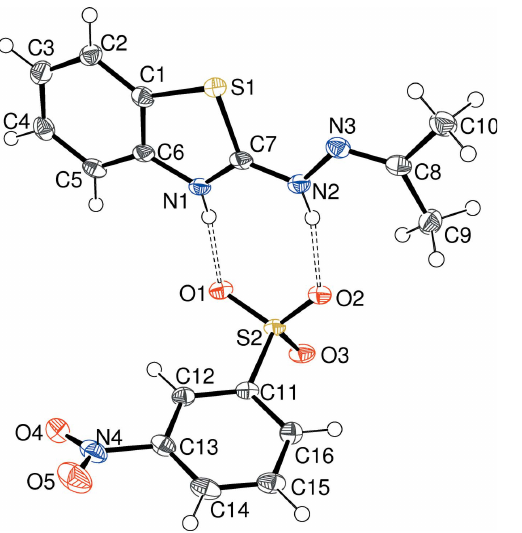
Figure 1 The asymmetric unit of (I) showing 50% displacement ellipsoids. Hydrogen bonds are indicated by double-dashed lines.